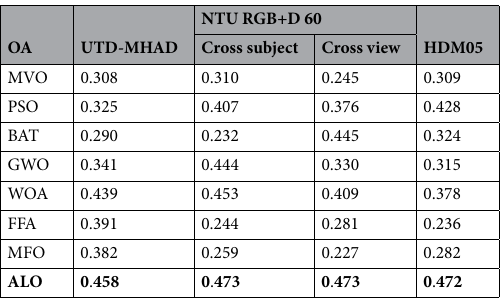
Table 10. Comparison of results obtained by performing stability test on selected features from ALO algorithm along with other popular metaheuristics used for comparison.